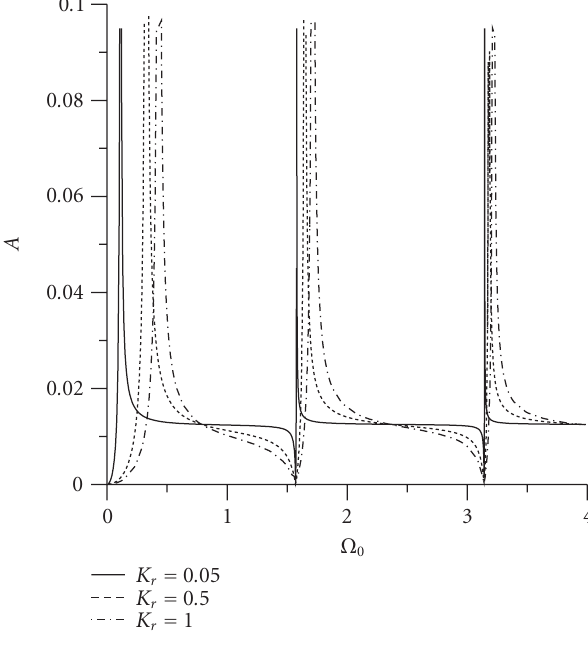
Figure 4.6. Amplitude-frequency curves according to the analytical solution (4.2) for K r = 0 . 05, K r = 0 . 5, and K r = 1 .